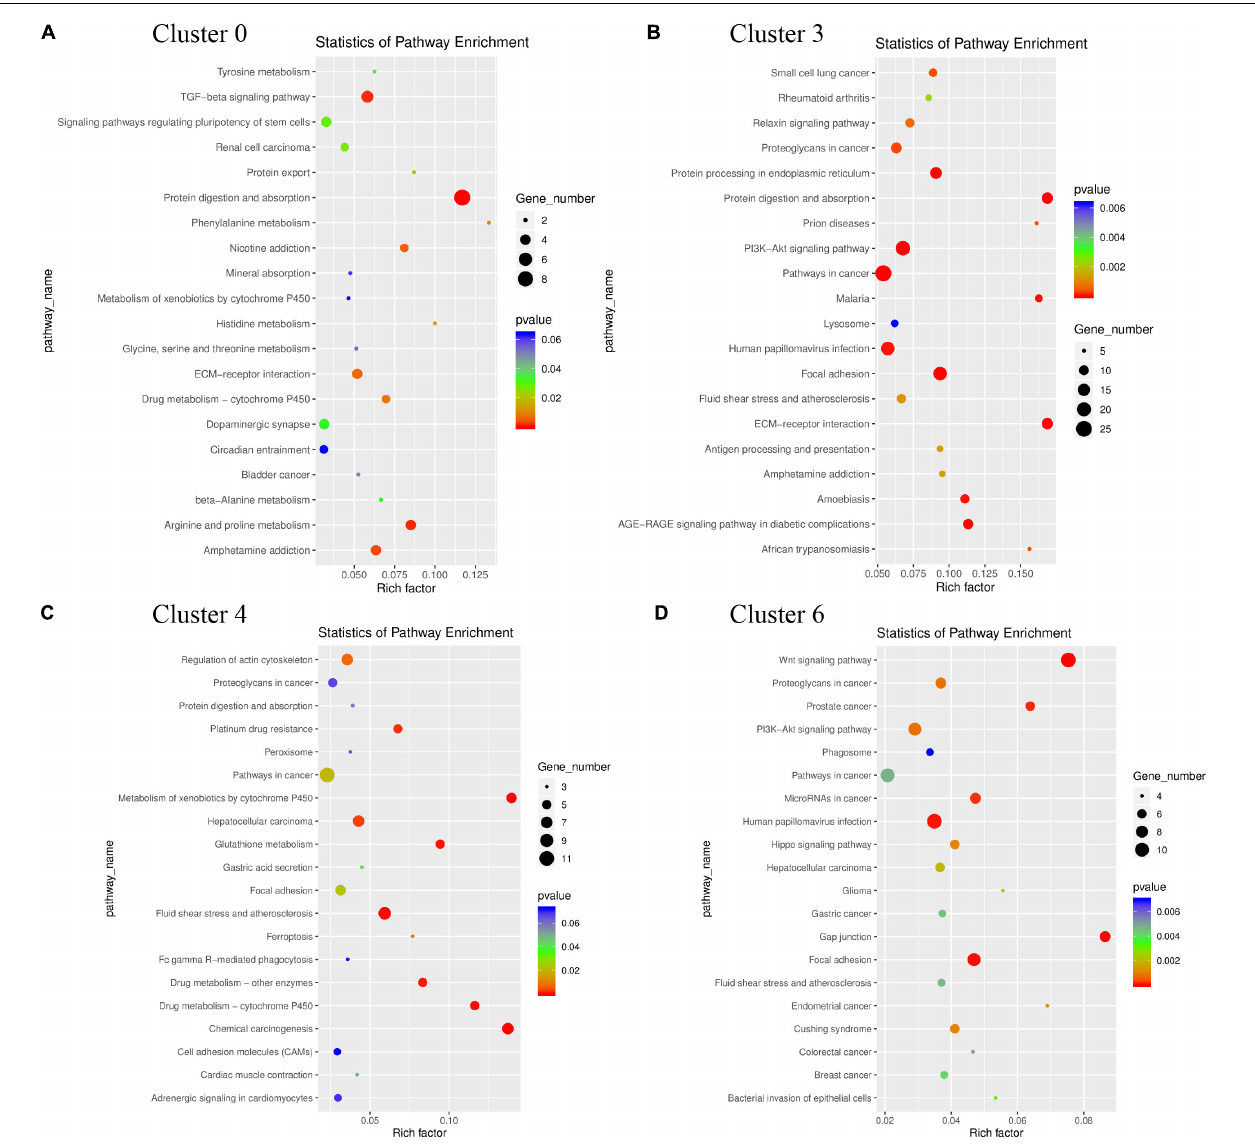
FIGURE 11 | KEGG pathways functional enrichment analyses for the heterogeneity of cluster 0 (A) , cluster 3 (B) , cluster 4 (C) , cluster 6 (D) after re-clustered. The triangle size indicates the significance and corresponding significance values displayed as log10 ( P